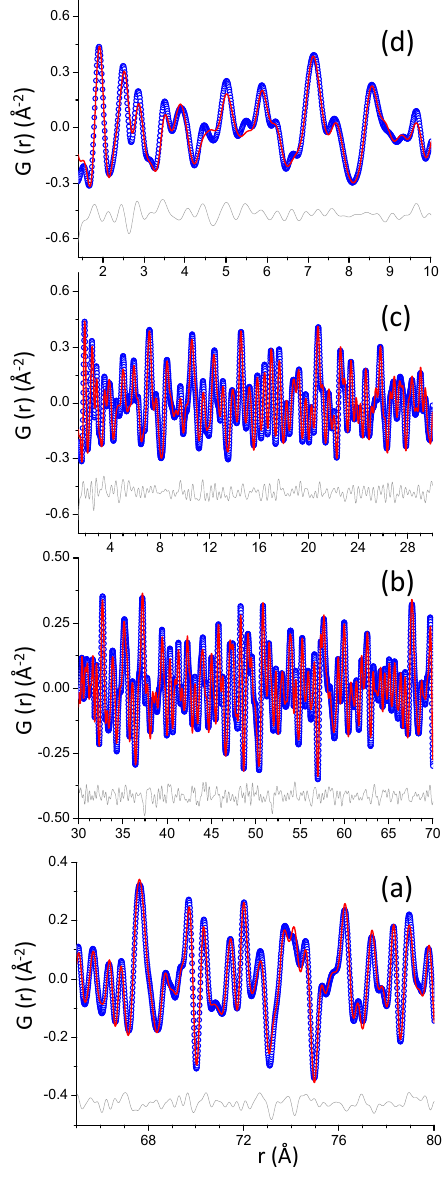
Figure 6. Experimental (blue circles) and fitted (red solid line) PDF for the CaAl 2 O 4 paste hydrated with w/s = 0.55 at 35 °C ( a ) from 65–80 Å; ( b ) from 30–70 Å; ( c ) from 1.4–30 Å and ( d ) from 1.4–10 Å represents a better visualization of the first interatomic distance peaks. Difference curves are shown as grey lines.